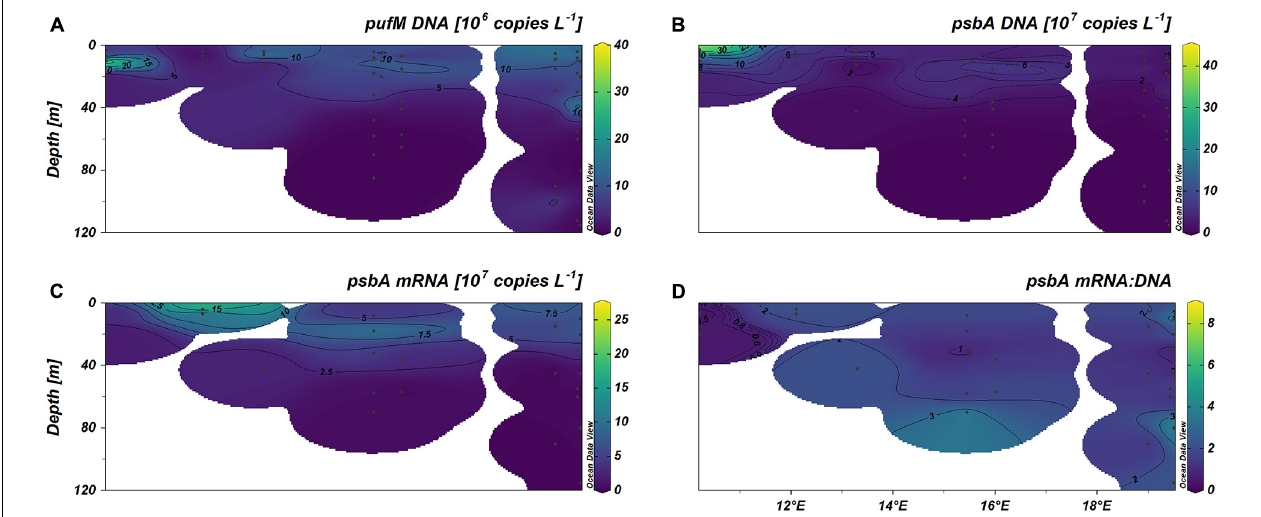
FIGURE 11 | (A,B) Spatial distribution of gene copy number (DNA) of the AP and OP photosynthetic gene ( puf M and psb A, respectively), (C) spatial distribution of transcript (mRNA) abundance of the OP photosynthetic gene ( psb A), (D) transcriptional activity of psb A expressed as the ratio of mRNA to DNA.